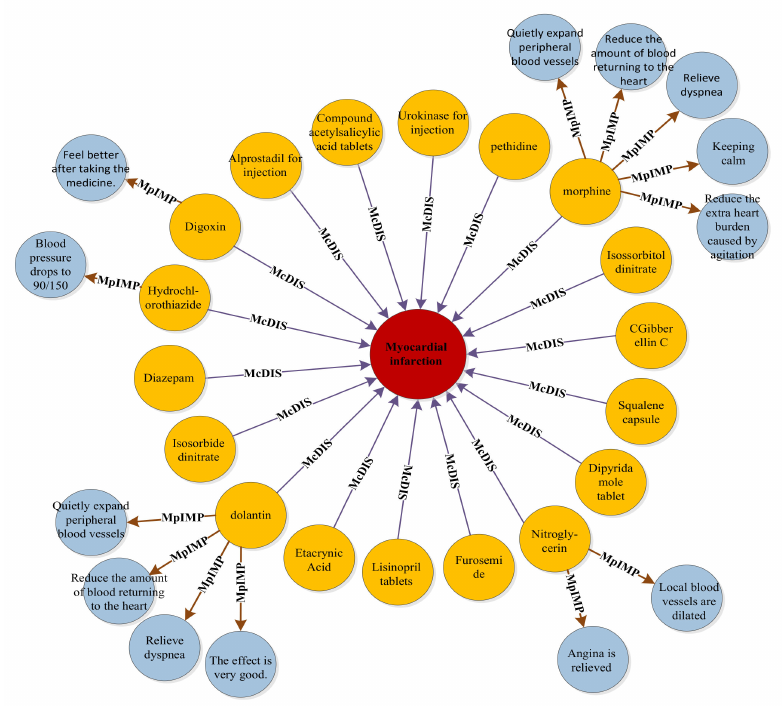
Figure 3. Drugs and drug effects related to myocardial